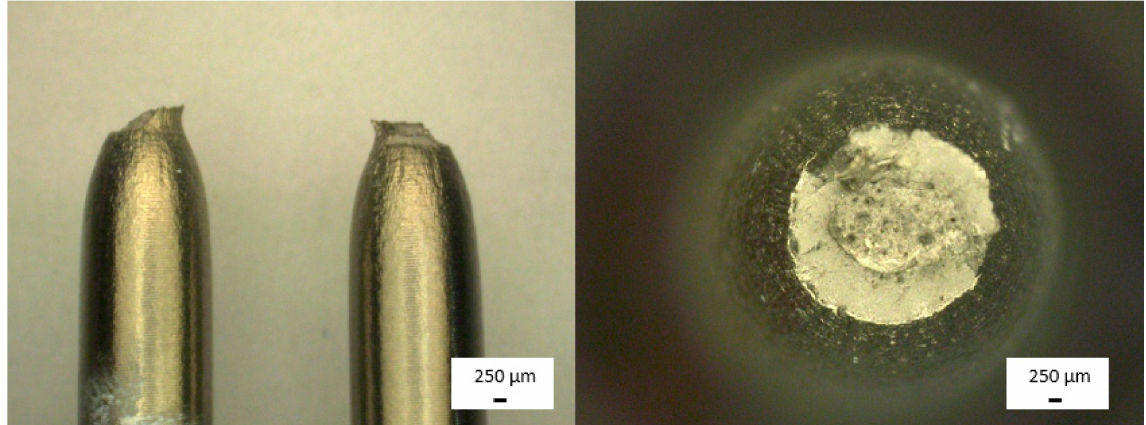
Figure 11. Light microscopy images of Ti-13Nb-13Zr samples after static tensile